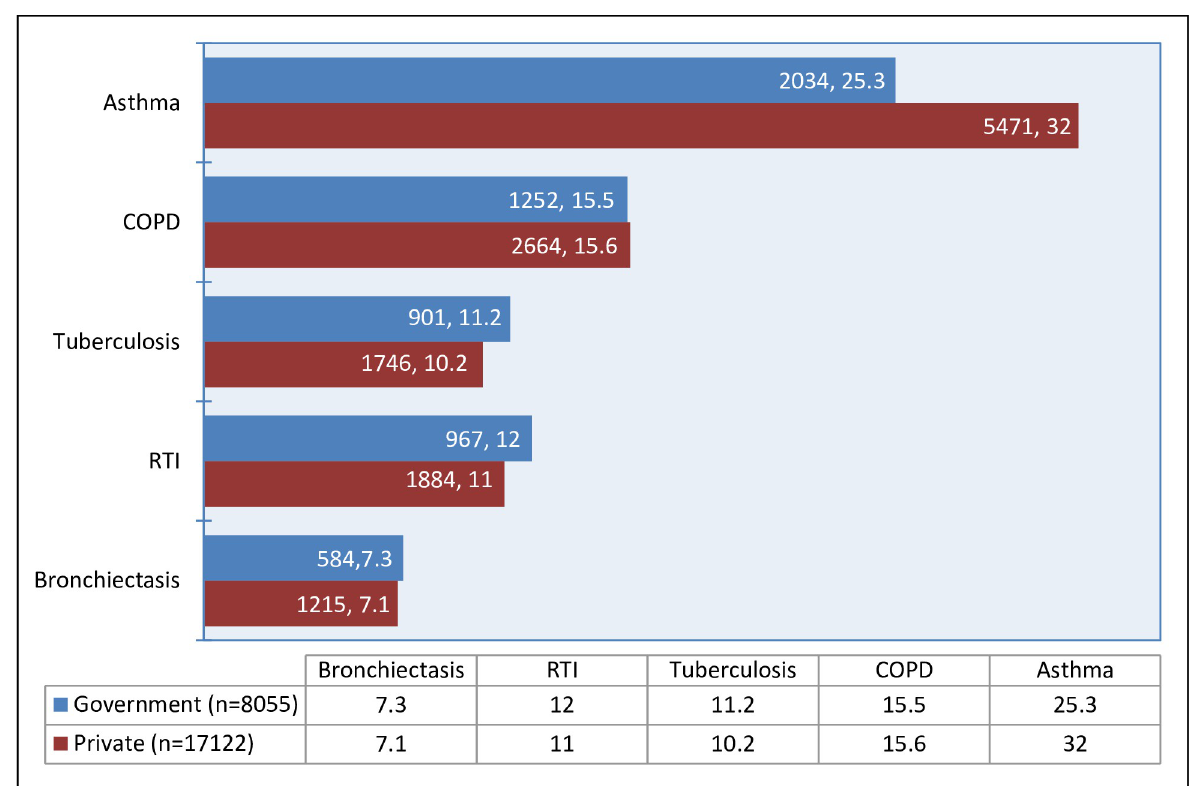
Fig 5. Clinical care settings vs. respiratory diagnoses in the SWORD study. Patients presenting in the public vs. private sector as per the major diagnoses. Asthma was seen more commonly at private settings (p < 0.001) while RTIs and tuberculosis in the public healthcare services (p < 0.05). COPD and bronchiectasis did not show significant difference (p >